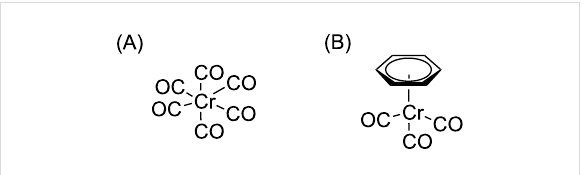
Figure 1: Structure of (A) chromium(0) hexacarbonyl and (B) benzene- chromium(0)